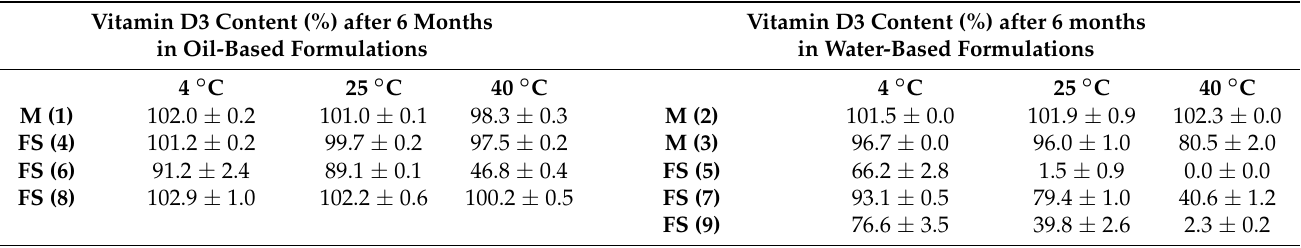
Vitamin D3 Content (%) after 6